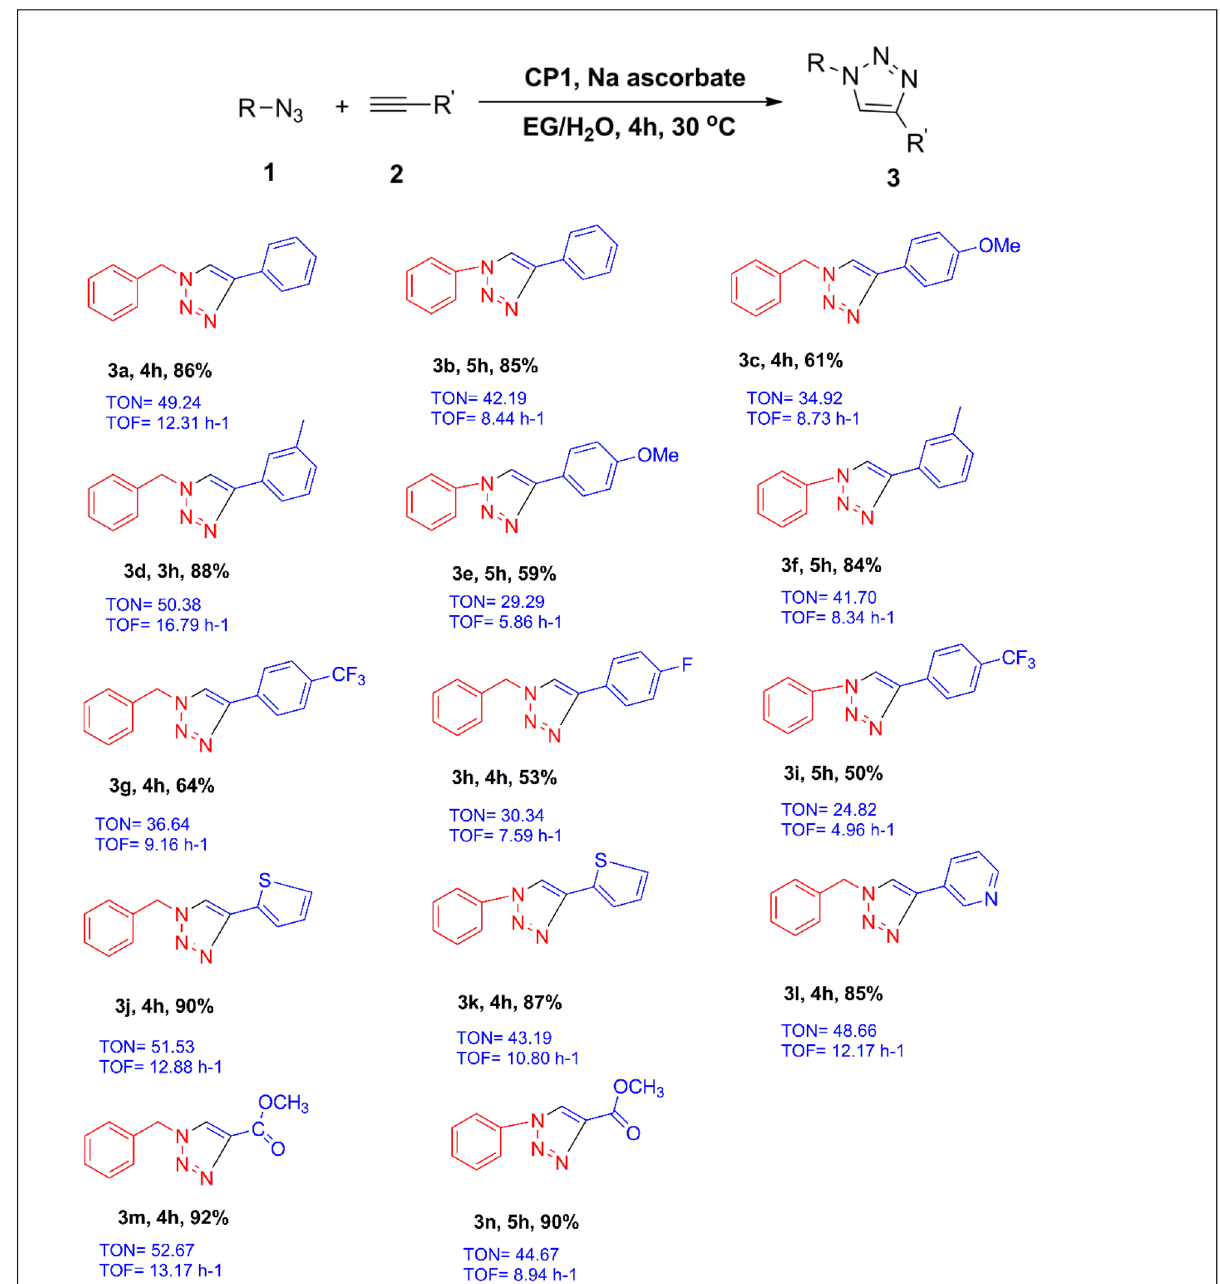
Table 2. Substrate scope on 1D copper-based coordination polymer catalyzed azide/alkyne cycloaddition reaction a . a Reaction conditions: azide (1.0 mmol), alkyne (1.2 mmol), CP1 (2 mol%), Na ascorbate (3